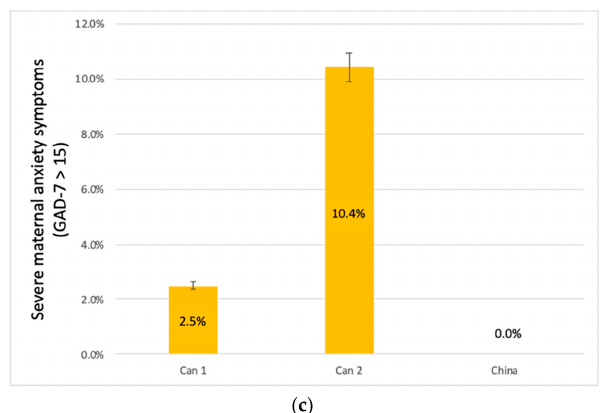
Figure 3. (a) Mean maternal anxiety score using the Generalized anxiety disorder 7-item scale (GAD-7) * p < 0.001 between Canada 1/China and between Canada 2/China Canada 1 (Can1), n = 1563; Canada 2 (Can2), n = 115; China, n = 438. missing values: Canada 1, n = 241 ; Canada 2, n = 20 ; China, n = 46.* p < 0.05. Can 1: Canada 1/Can 2: Canada 2. (b) Moderate to severe maternal anxiety symptoms using the Generalized Anxiety Disorder 7-item scale (GAD-7) cut-off (>9). * p < 0.001 between Canada 1/China and between Canada 2/China. Can 1: Canada 1/Can 2: Canada 2. (c) Severe mater-